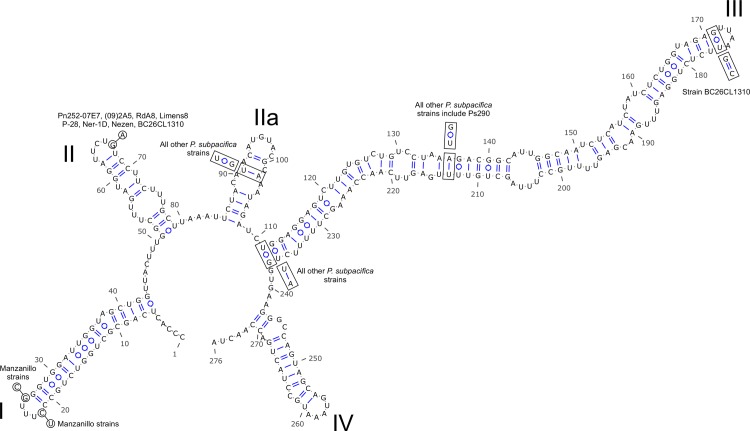
Secondary structure of Pseudo-nitzschia subpacifica strain Ps291 (Todos Santos Bay) ITS2, with comparisons to other P. subpacifica strains.